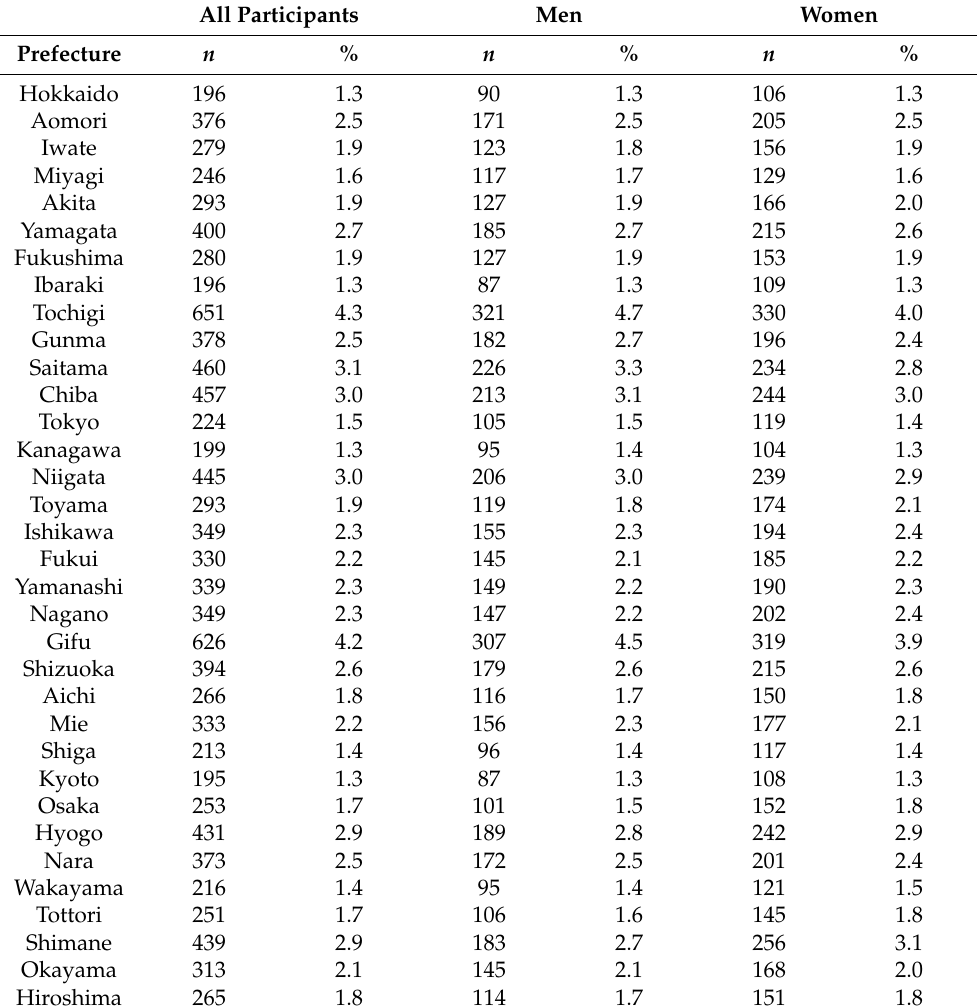
Table 1. Number of participants by